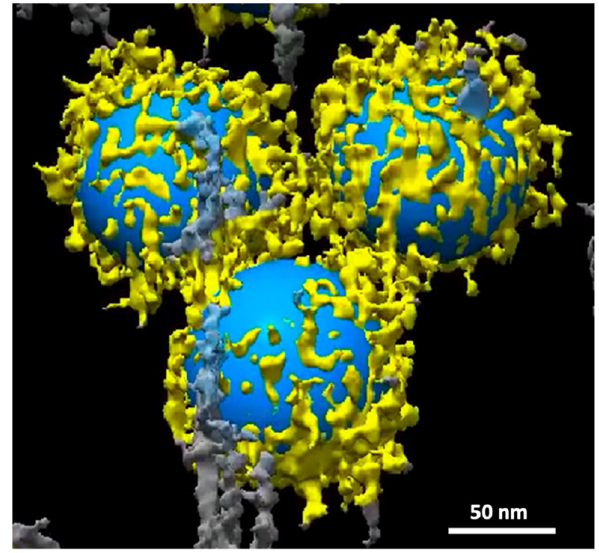
Fig. 3 Representation of distribution pattern of clusters of biomolecules of the surface of individual NPs. The image is a snapshot generated from the 3D volume of Supplementary Movie 4.